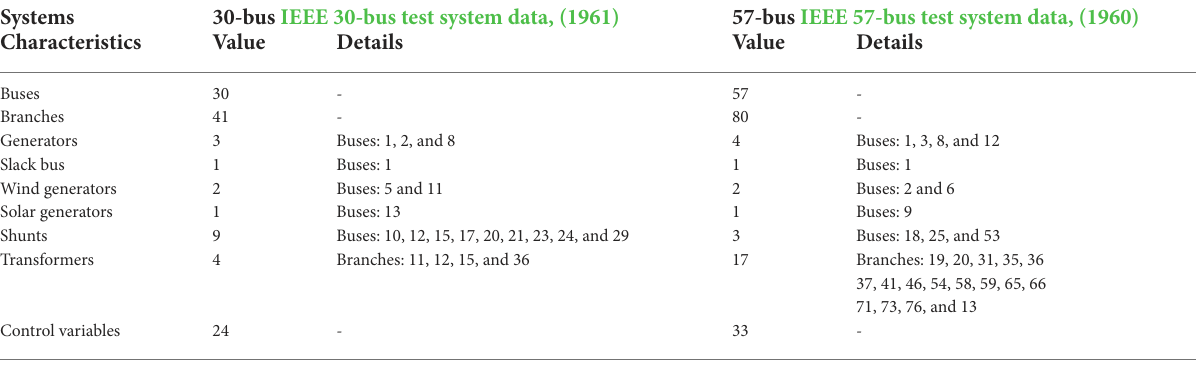
TABLE 1 Characteristicsofthesystems.